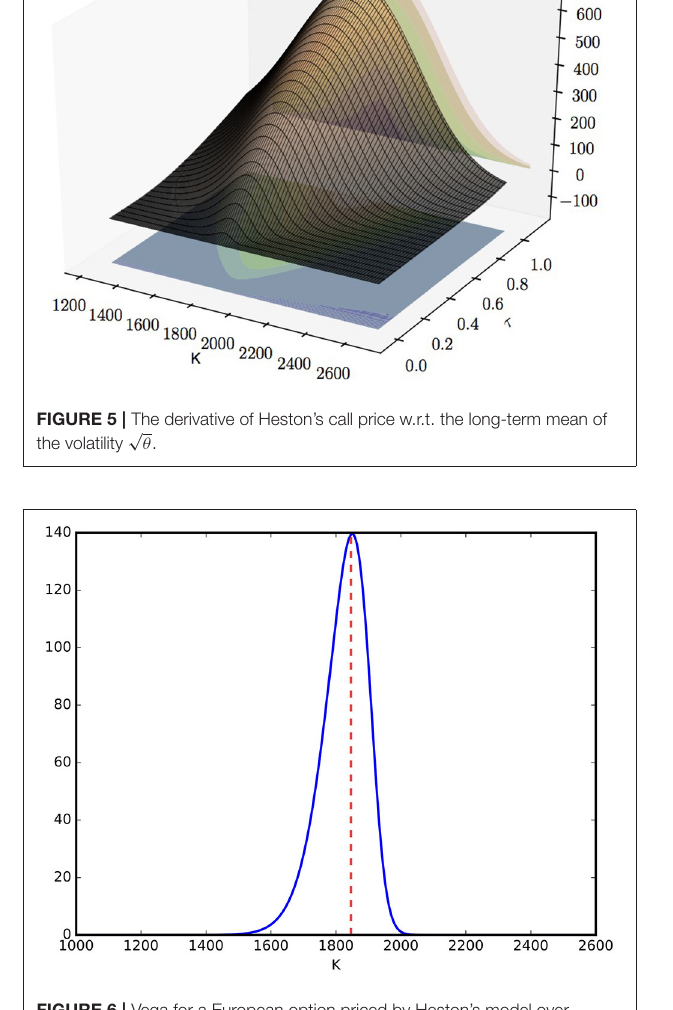
FIGURE 6 | Vega for a European option priced by Heston’s model over various strikes. It is strictly positive and has a global maximum near the spot price of the underlying asset (indicated by the red dashed line).